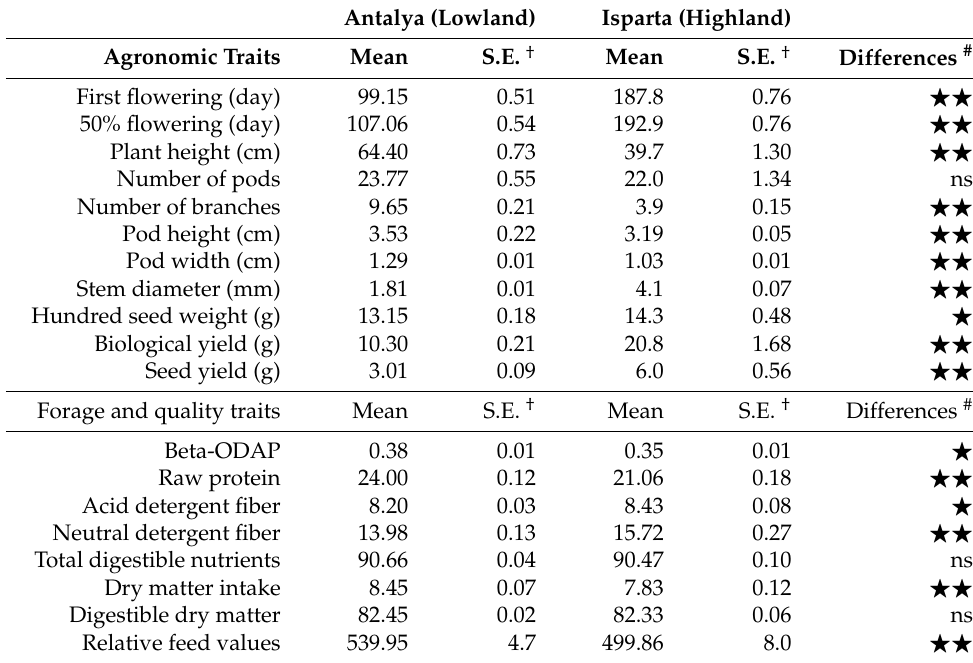
Table 2. Means and standard errors for 11 quantitative and eight quality traits in 94 genotypes produced in Antalya (lowland) and Isparta (highland).